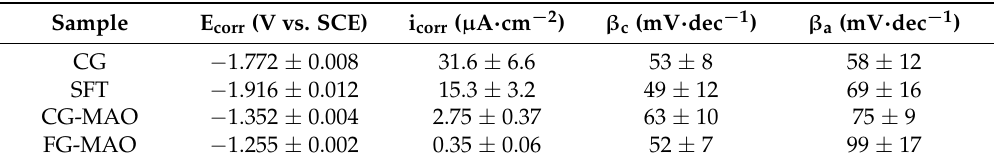
Figure 7. Potentiodynamic polarization curve of all samples immersed in simulated body fluid (SBF). Table 2. Main electrochemical parameters of all samples immersed in SBF solution.